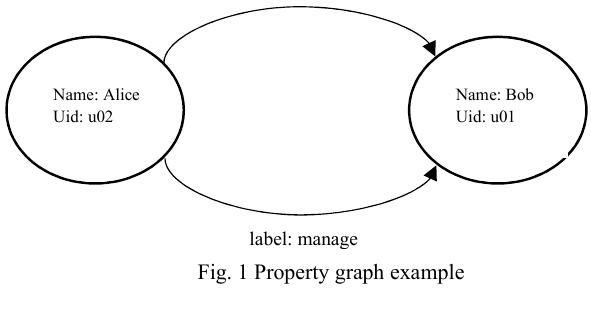
Fig. 1 Property graph